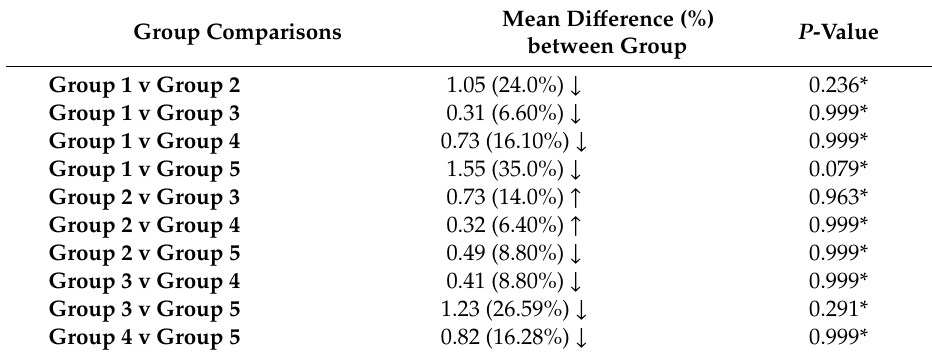
Table 4. Inter-group statistical comparison of mean flexural